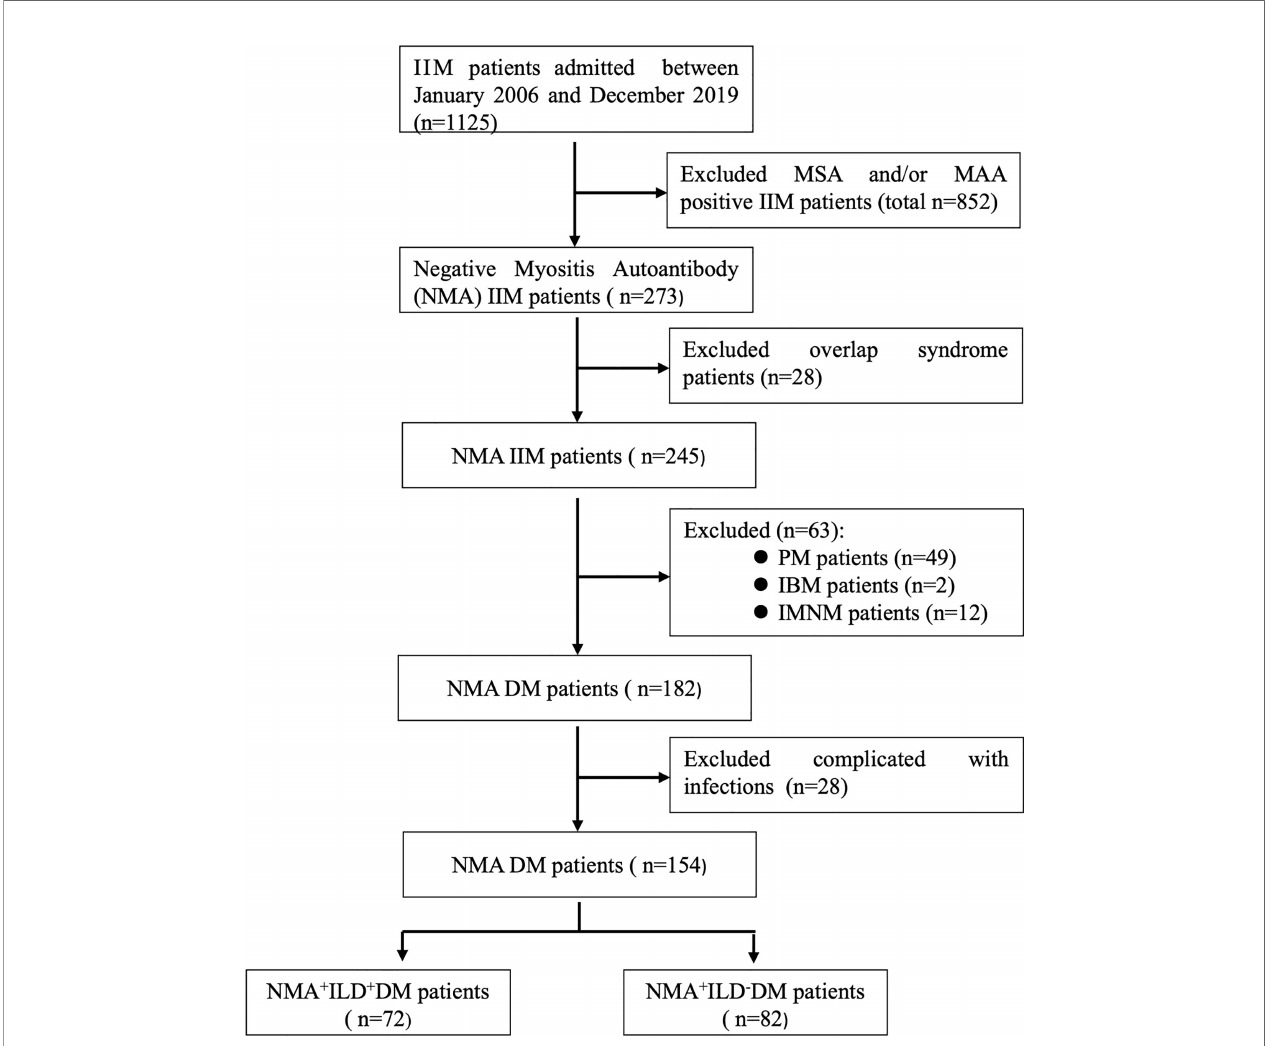
FIGURE 1 | Flowchart of DM-ILD patients with negative MSA/MAA. IIM, idiopathic in fl ammatory myopathy; MSA, myositis speci fi c autoantibody; MAA, myositis associated autoantibody; PM, polymyositis; IBM, inclusion body myopathy; IMNM, immune mediated necrotizing myopathy; ILD, interstitial lung